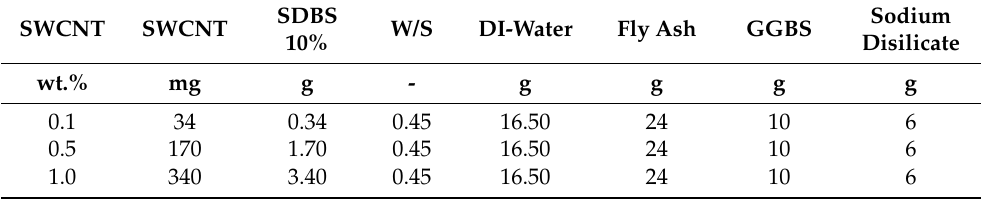
Table 2. One-part SWCNT-alkali-activated nanocomposites’ chemical laboratory-scale mix design. SWCNT